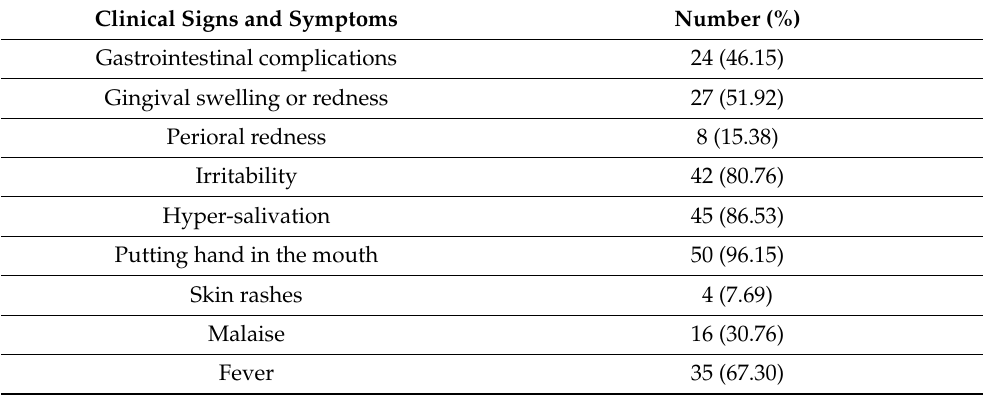
Table 2. Signs and symptoms of children in group B with at least one erupting tooth.